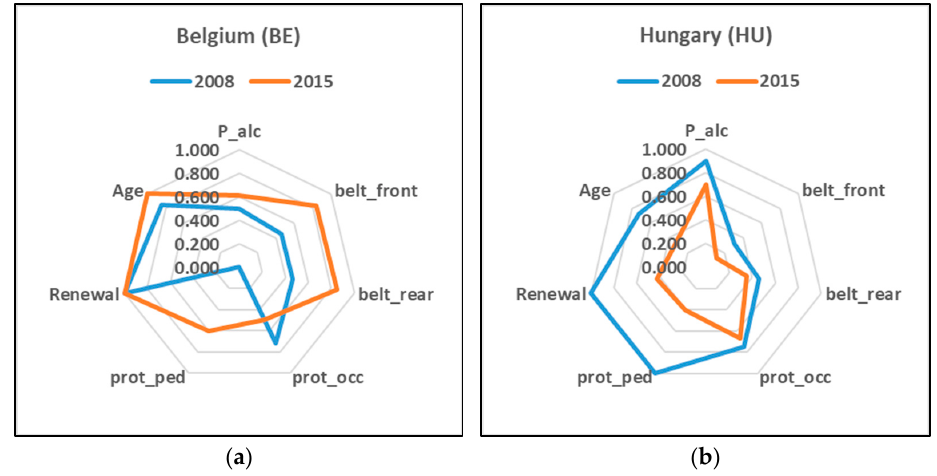
Figure 5. The normalized SPI values for ( a ) Belgium and ( b ) Hungary over